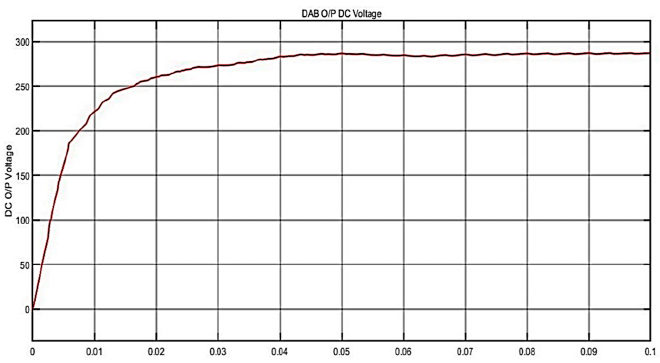
Figure 14. Output voltage waveform.